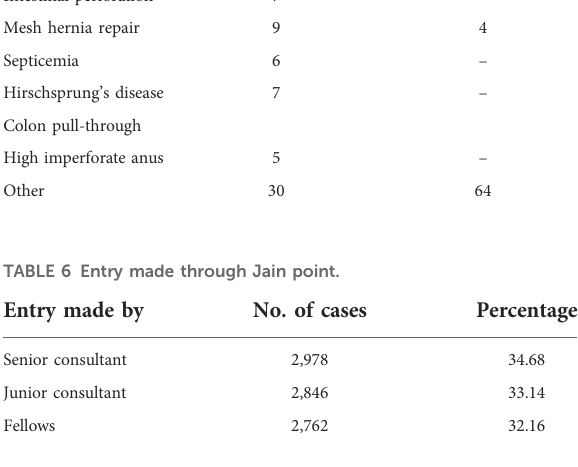
Table 5B : General surgery patients, in contrast to the gynae group, underwent more previous laparoscopies (53.26%, 212 out of 398) than previous laparotomies (46.7%, 186 out of 398) procedure. Cholecystectomy and